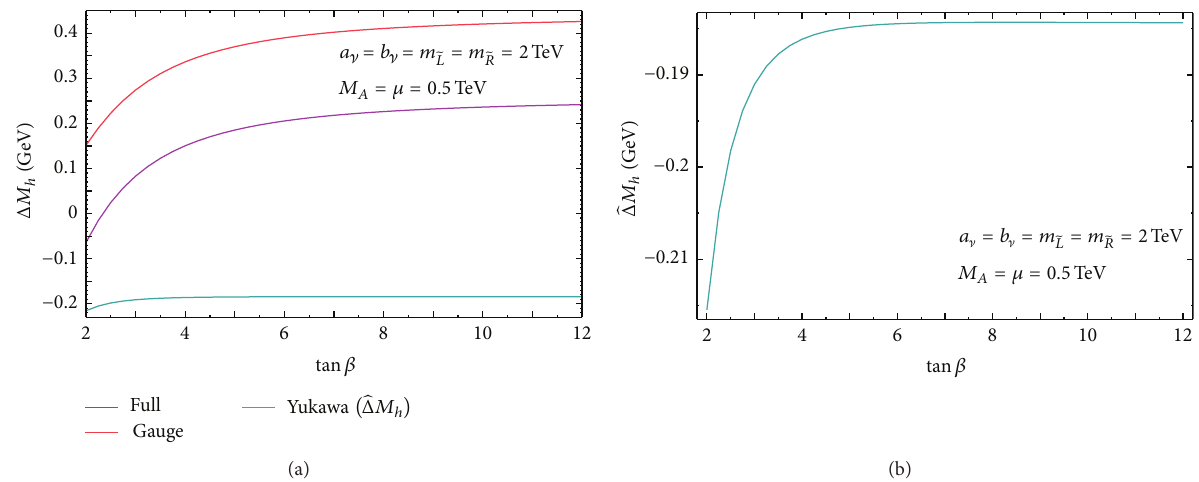
Figure 4: (a) The full, gauge, and Yukawa contributions to Δ𝑀 ℎ defined in (83), (84a), and (84b), respectively, are plotted as functions of ̂ Δ𝑀 𝛽 . tan 𝛽 . (b) Zoom of ℎ as a function of tan